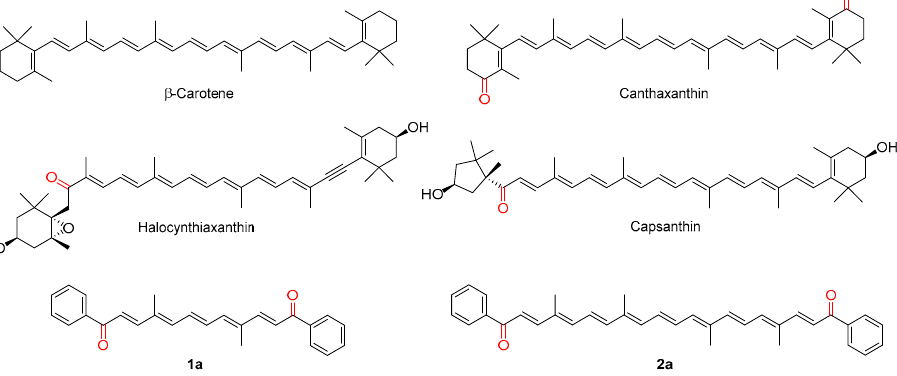
Figure 1. The structures of b ‐ carotene, oxo ‐ carotenoids at the ring or at the chain, and novel oxo ‐ carotenes 1a and 2a , designed for superoxide radical scavenging assay. carotenes 1a and 2a , designed for superoxide radical scavenging